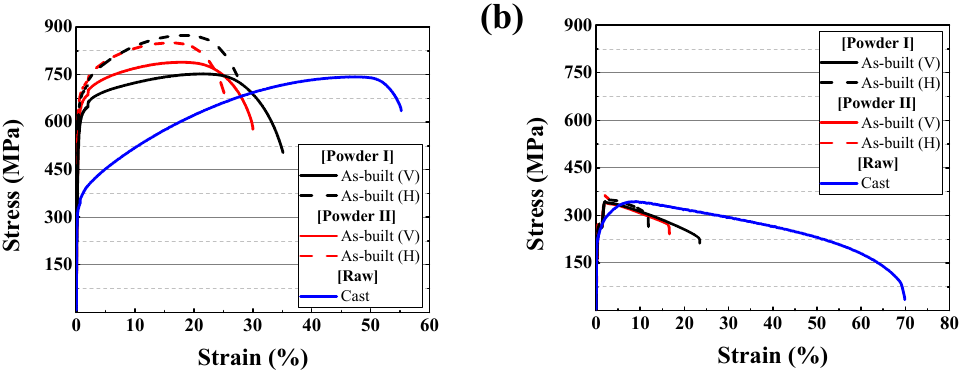
Figure 8. Tensile test stress–strain relationship results at ( a ) room temperature and ( b ) high temperature (816 °C).